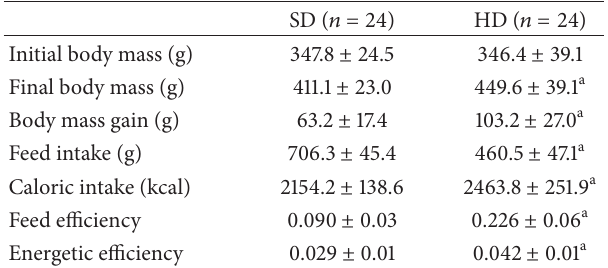
Table 2: Mean values of body mass, feed intake, caloric intake, and feed and energetic efficiency during the first 4 weeks of our study (without exercise